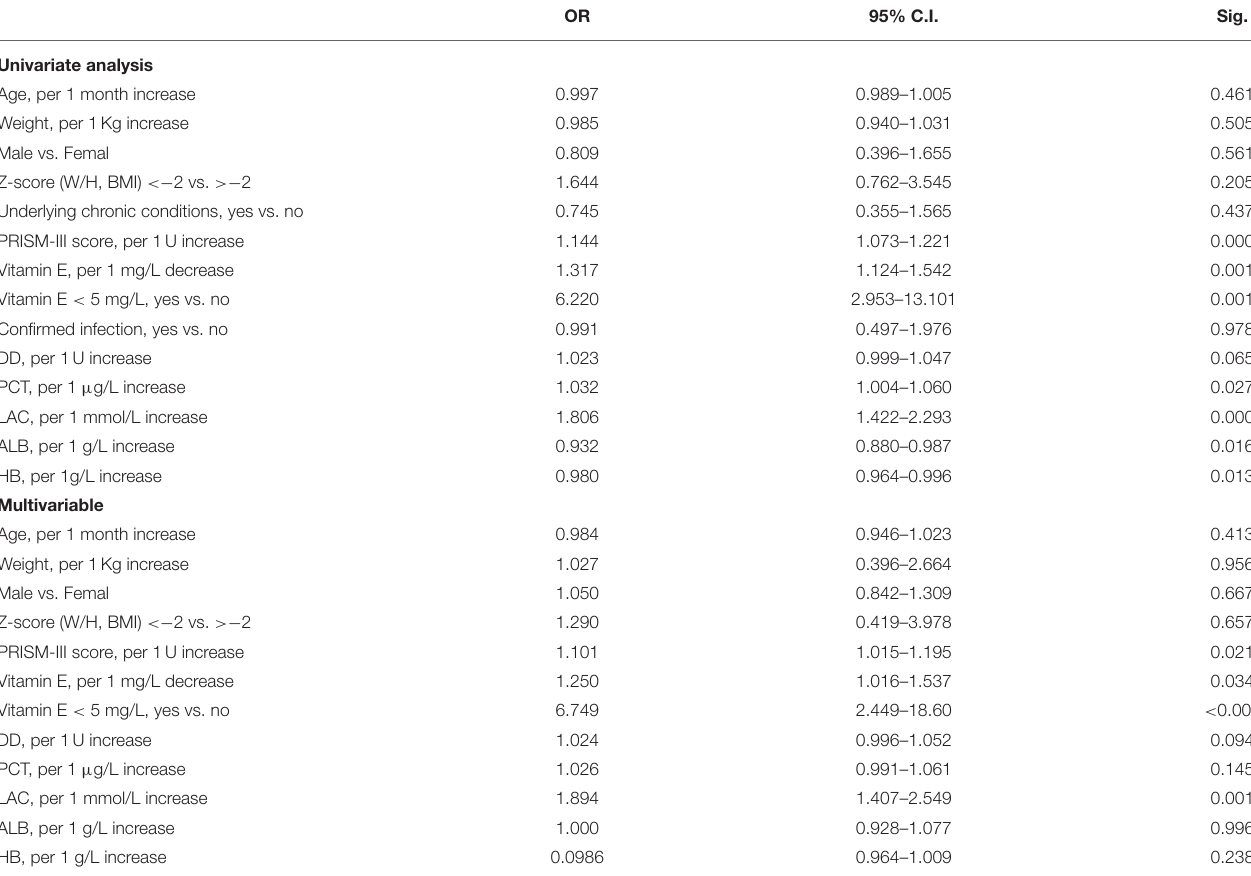
TABLE 4 | Logistic regression models assessing the variables associated with septic shock. OR 95% C.I.